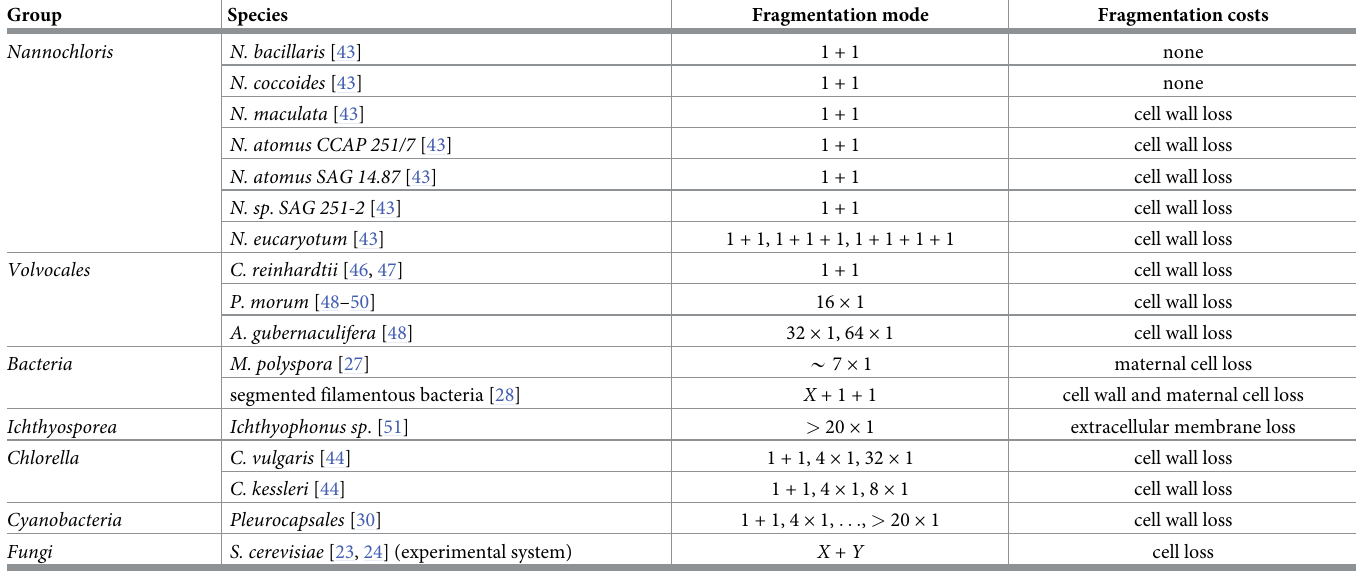
Table 1. List of species considered in this work and their life cycles. Group Species Fragmentation mode Fragmentation